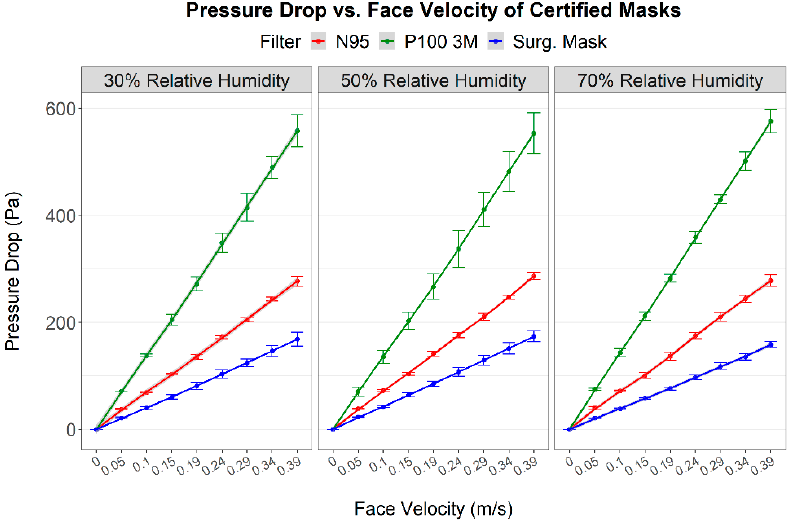
Figure 3. Pressure drop for single-layered certified materials as a function of face velocity. Facets represent the relative humidity during the experiment. Results are plotted as the average pressure drop from three runs, with the error bars representing the standard deviation.